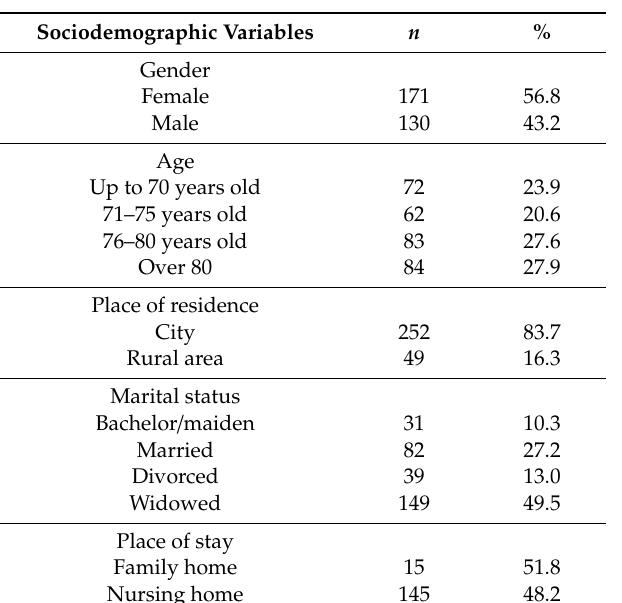
Table 1. Respondents’ sociodemographic data.